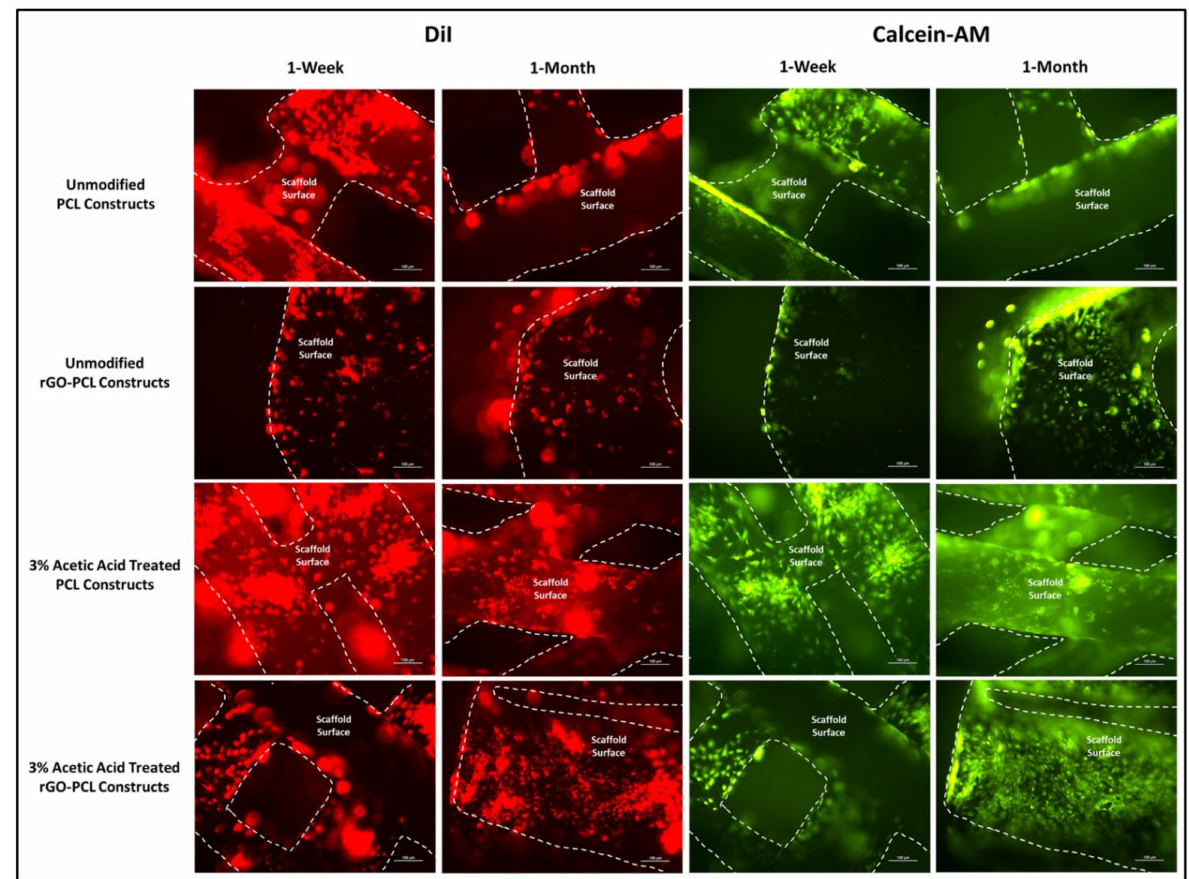
Figure 7. rDPSCs seeded on PCL and rGO-PCL constructs, both unmodified and etched with 3% acetic acid, under fluorescent imaging at 10 × magnification. DiI-labeled and Calcein-AM-stained cells are shown with scaffold surfaces highlighted via dashed lines. Cell populations on scaffolds were assessed at both 1-week and 1-month time points.